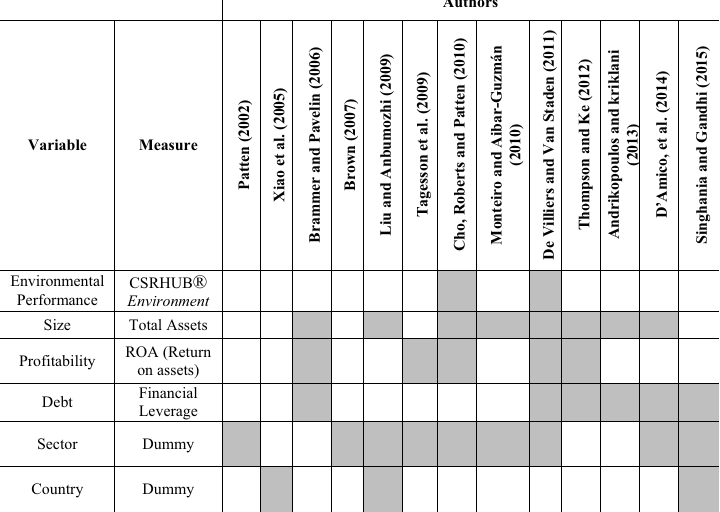
Figure 2. Variables used for the regression